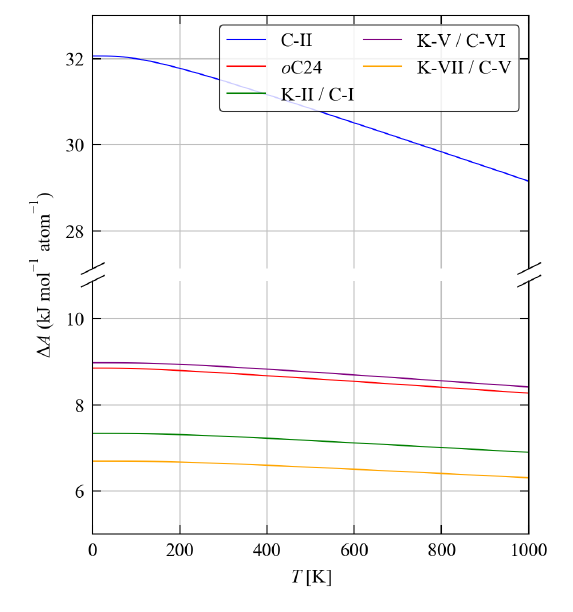
Figure 5. Calculated Helmholtz free energy differences ∆ A = ∆ U latt + ∆ U vib − T ∆ S vib as a function of temperature for the five Si framework structures relative to bulk diamond Si. Note the break in the y